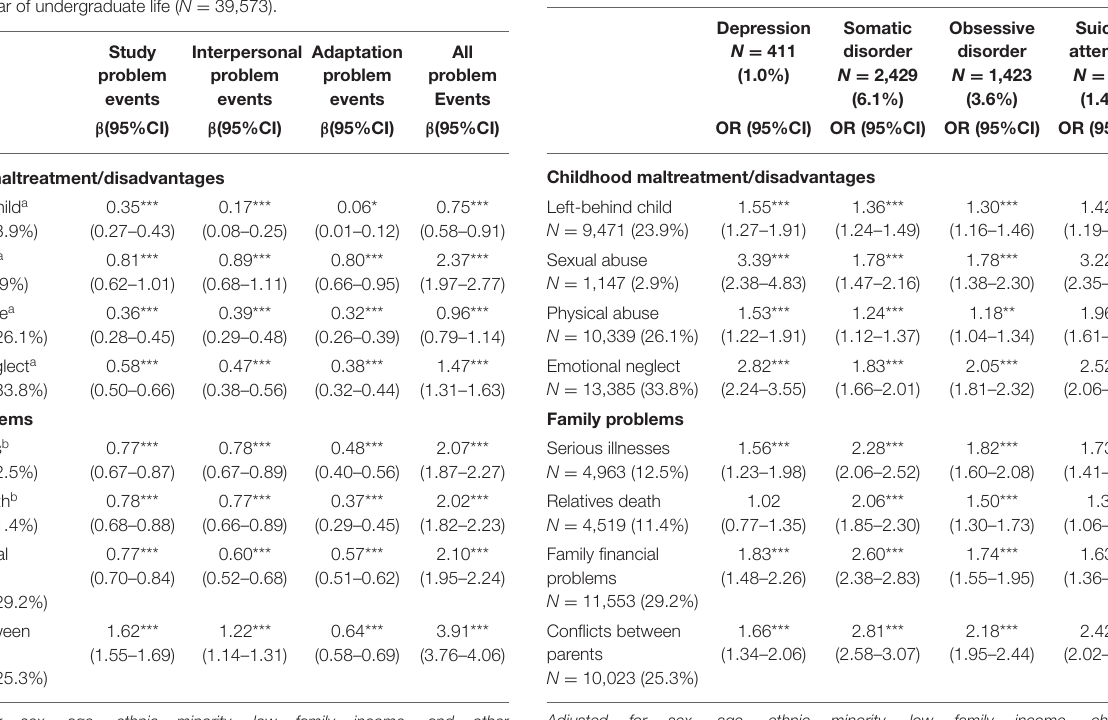
TABLE 3 | Independent associations between childhood maltreatment/family problems and psychiatric morbidity ( N =